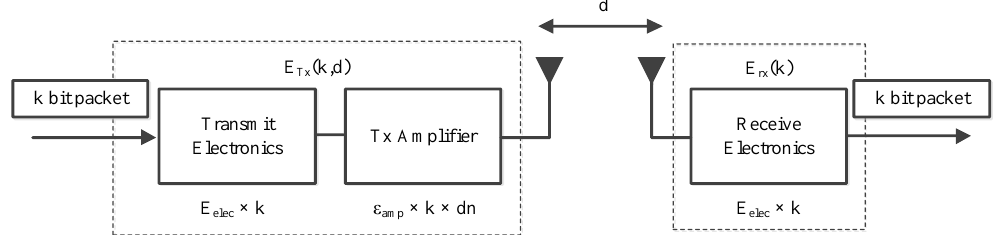
Figure 4. Radio energy dissipation